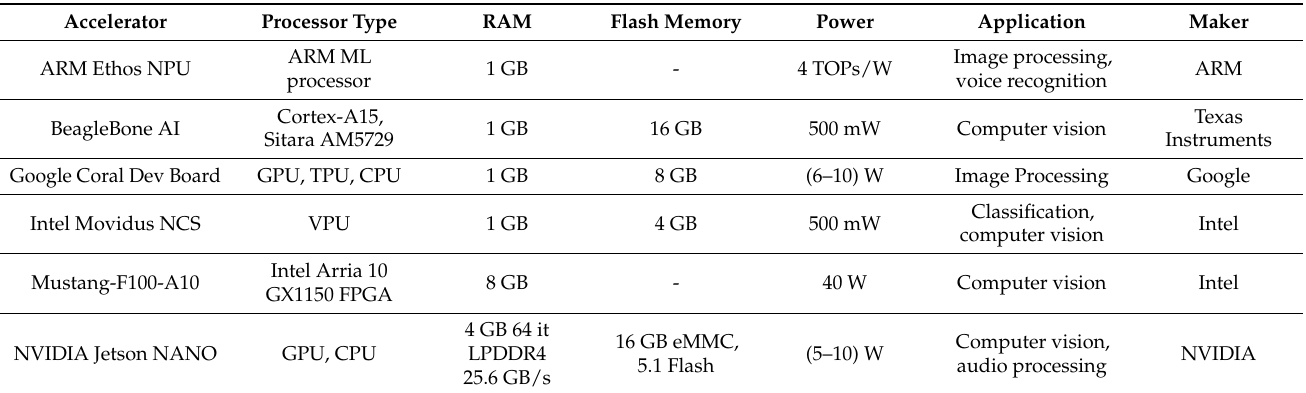
Table 13. Machine learning accelerators.